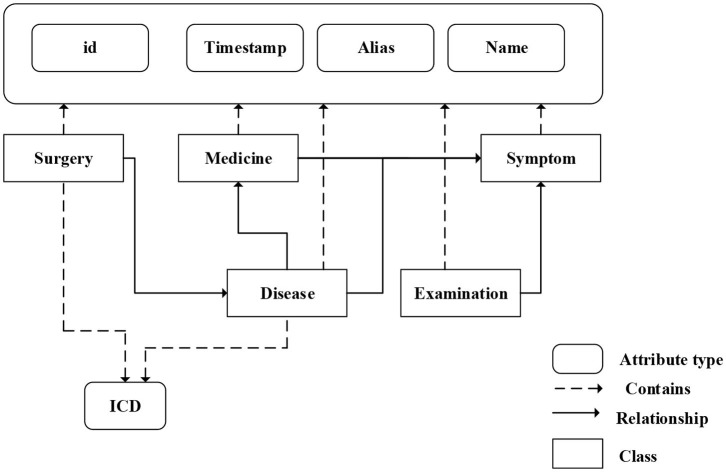
The ontology of medical knowledge graph.